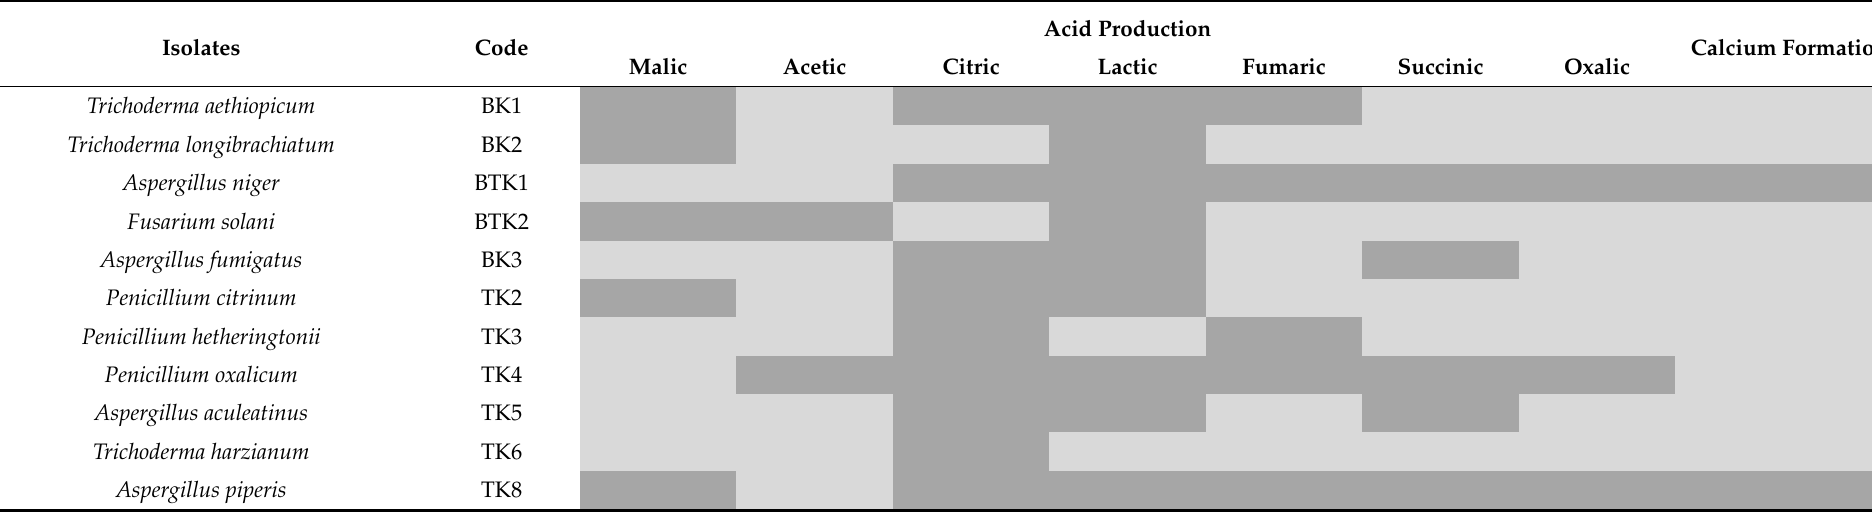
Table 1. Organic acids production and calcium formation of fungal isolates (dark gray indicate positive and light gray indicate negative